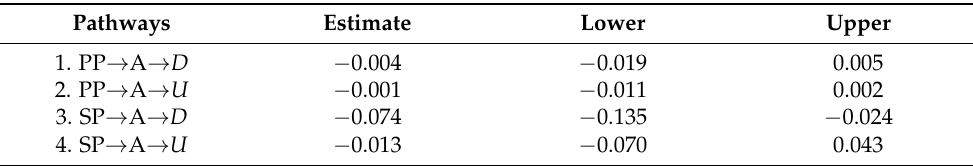
Table 2. Standardized indirect effects and 95% confidence